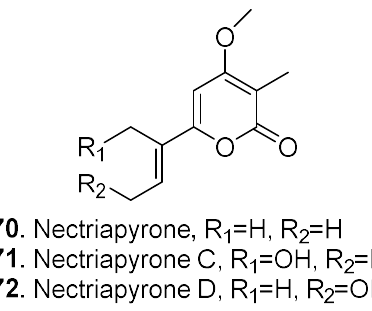
Figure 9. Monoterpenoids isolated from Clonostachys fungi.